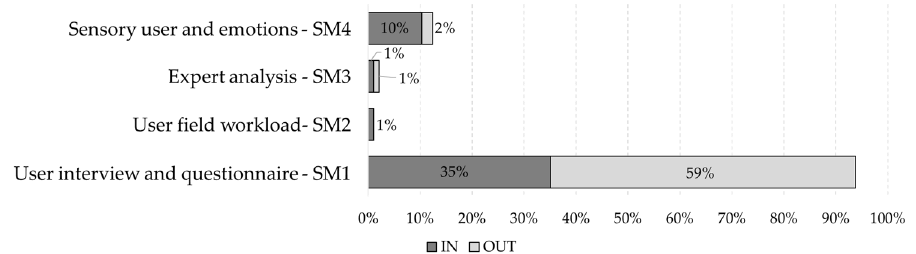
Figure 13. Number of items by type of evaluation of the subjective method and number evaluating within and outside the experience.